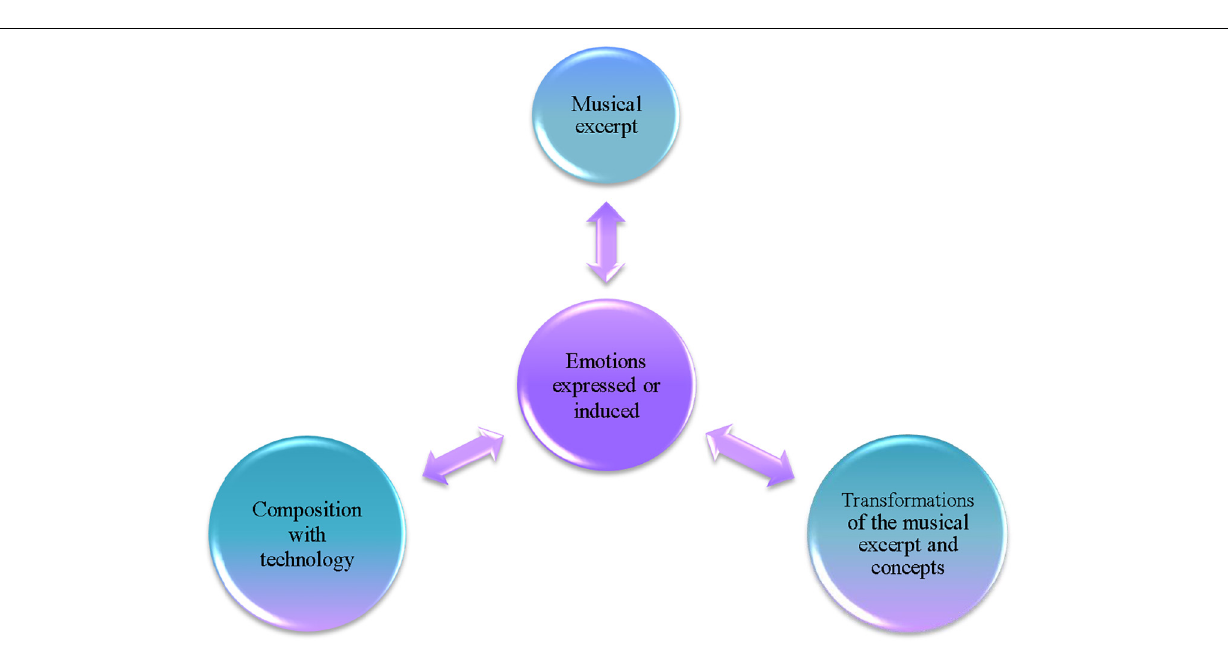
Frontiers in Education |